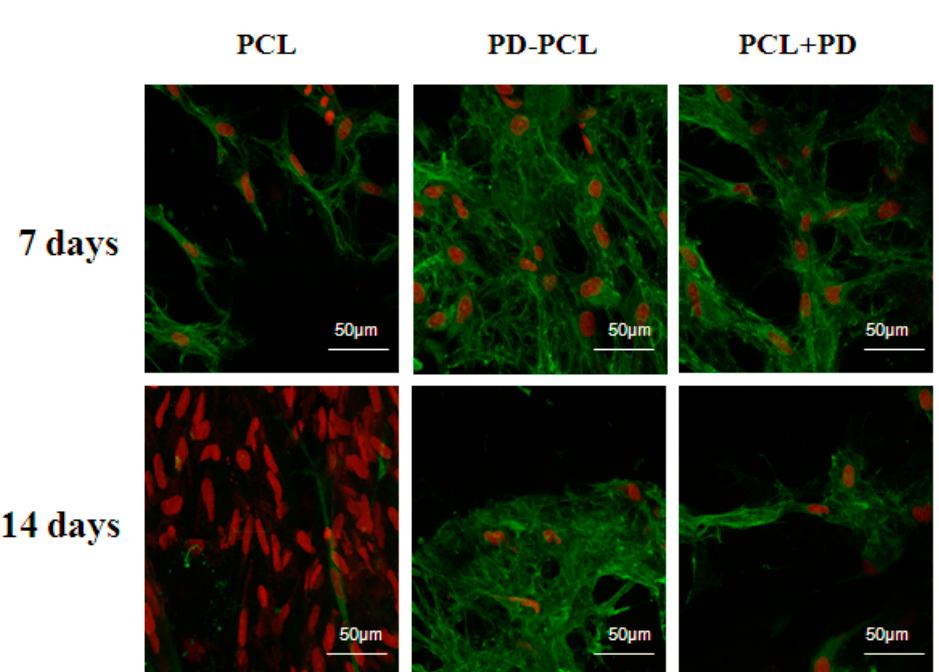
Figure 5. SEM Images of MSC cells grown for 7 and 14 days on: polycaprolactone scaffolds (PCL); PD-coated polycaprolactone scaffolds (PD-PCL); PCL scaffold with 48 µM PD added to the medium (PCL + PD).